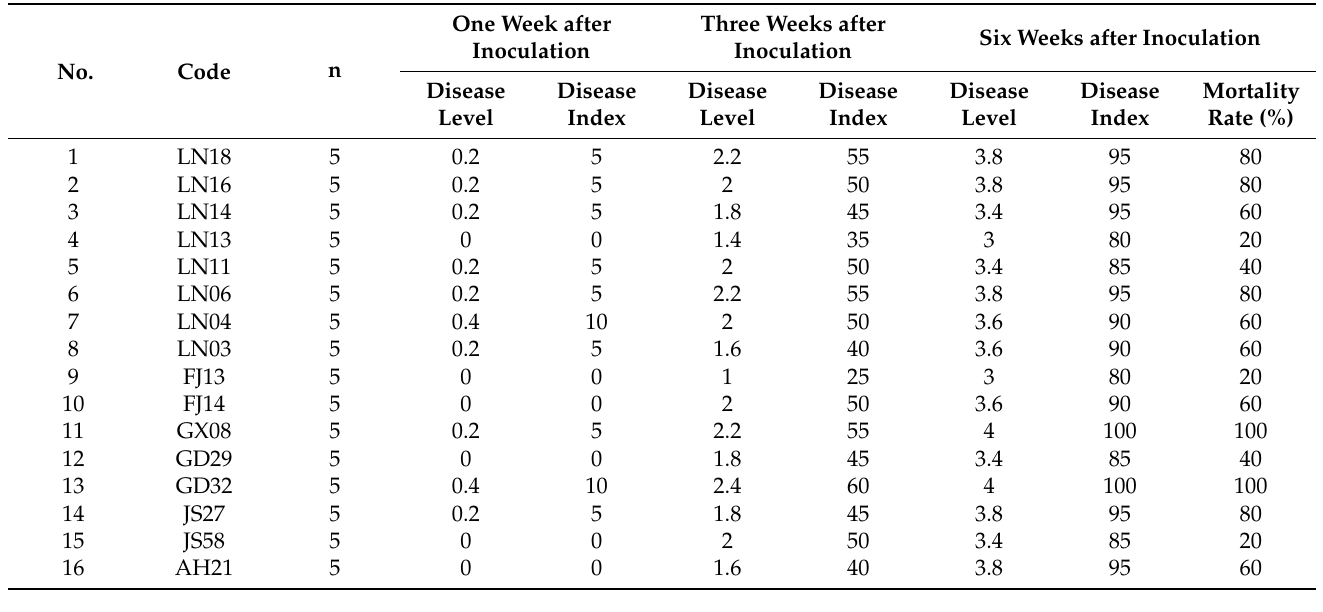
Table 5. The disease level and index and the mortality rate of P. thunbergii after artificial inoculation with different PWN strains.